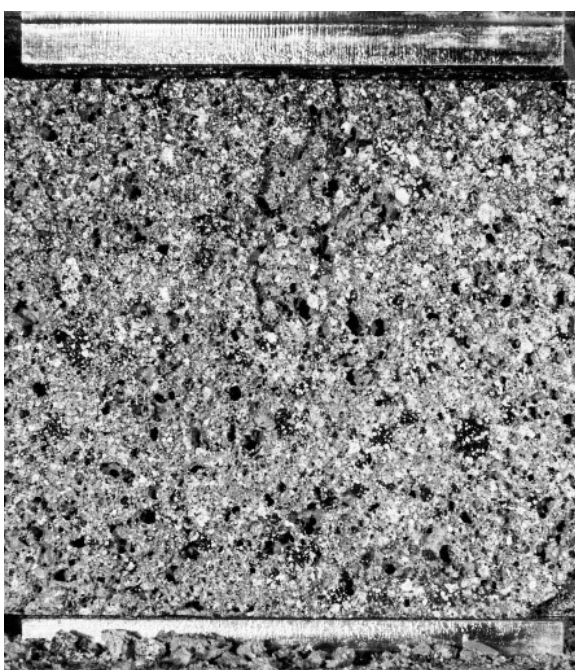
Figure 1. Random pattern on a sample in grayscale.